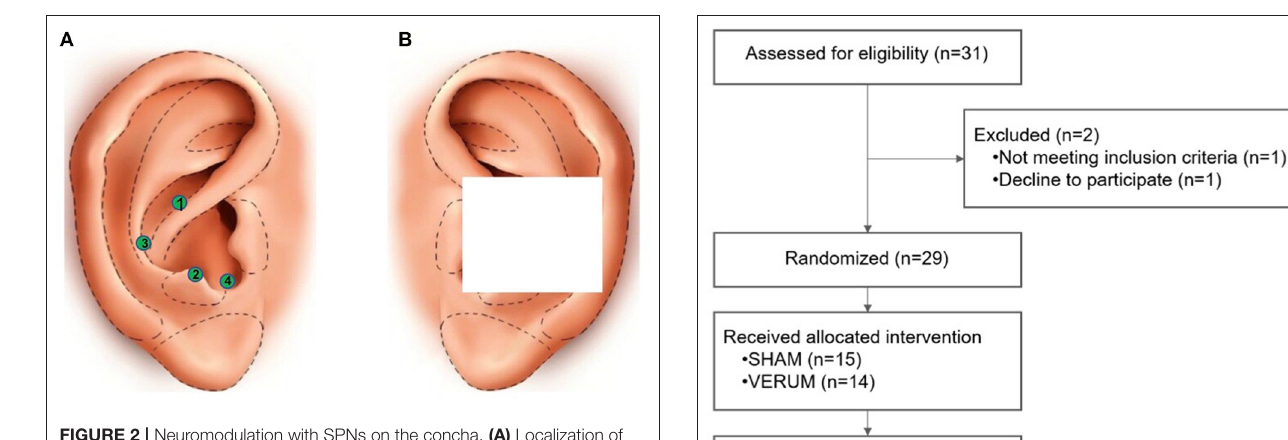
FIGURE 2 | Neuromodulation with SPNs on the concha. (A) Localization of the four selected acupoints, represented as green circles, of the concha, following the order indicated by the number in the circle: (1) master point of endoderm, (2) master point of reticular formation, (3) thymic plexus, and (4)